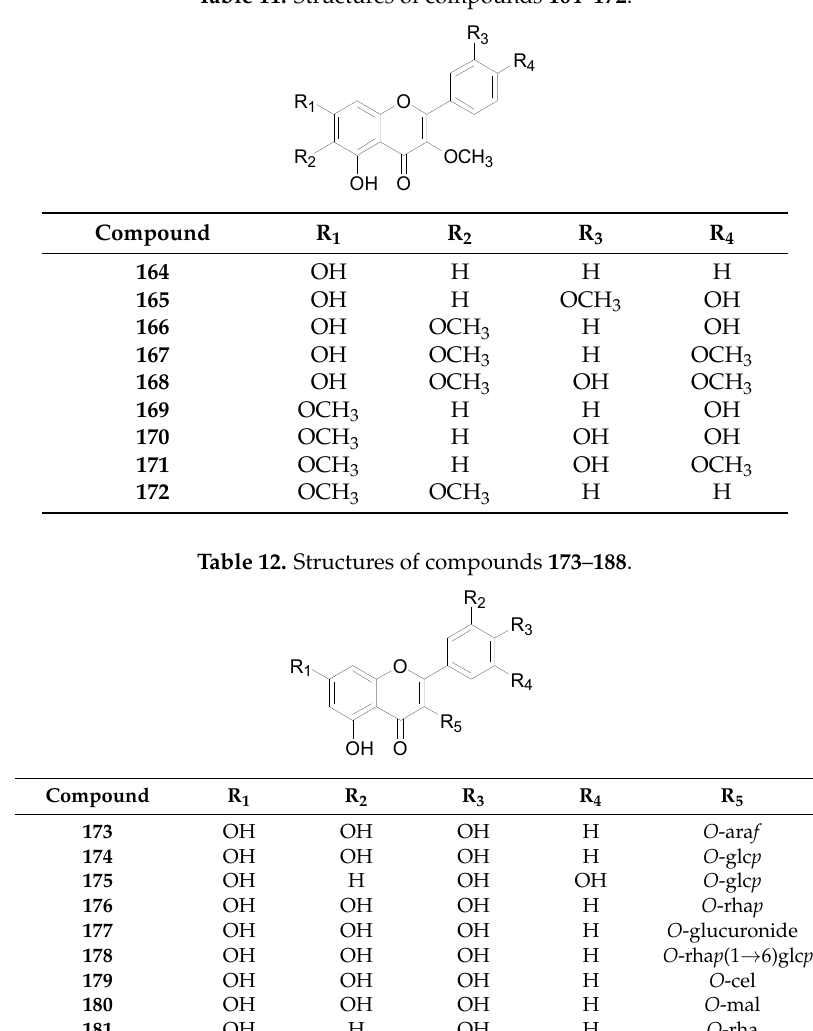
Table 11. Structures of compounds 164 – 172 .